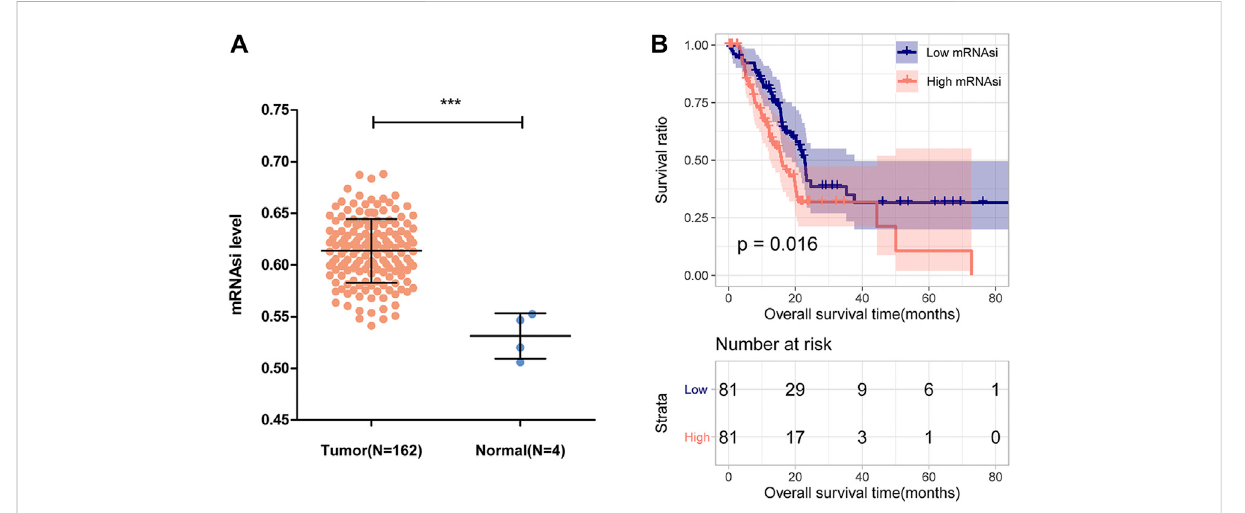
FIGURE 2 mRNAsi and its prognostic value in PAAD. (A) Comparison of mRNAsi between PAAD tumor tissues and normal tissues in the TCGA dataset. (B) Kaplan-Meier curve analysis of patients in the low- and high-mRNAsi